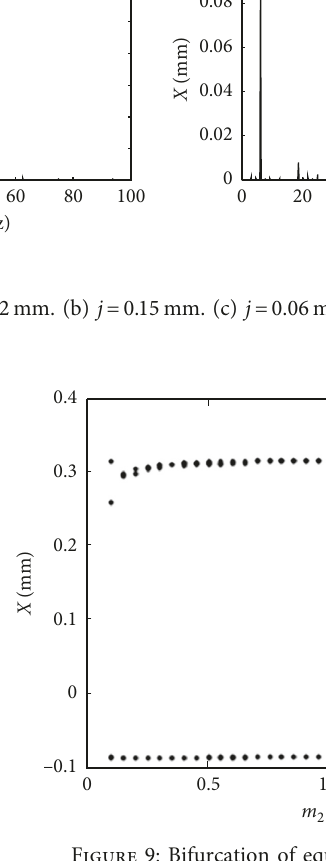
0.15mm. (c) j (cid:29)